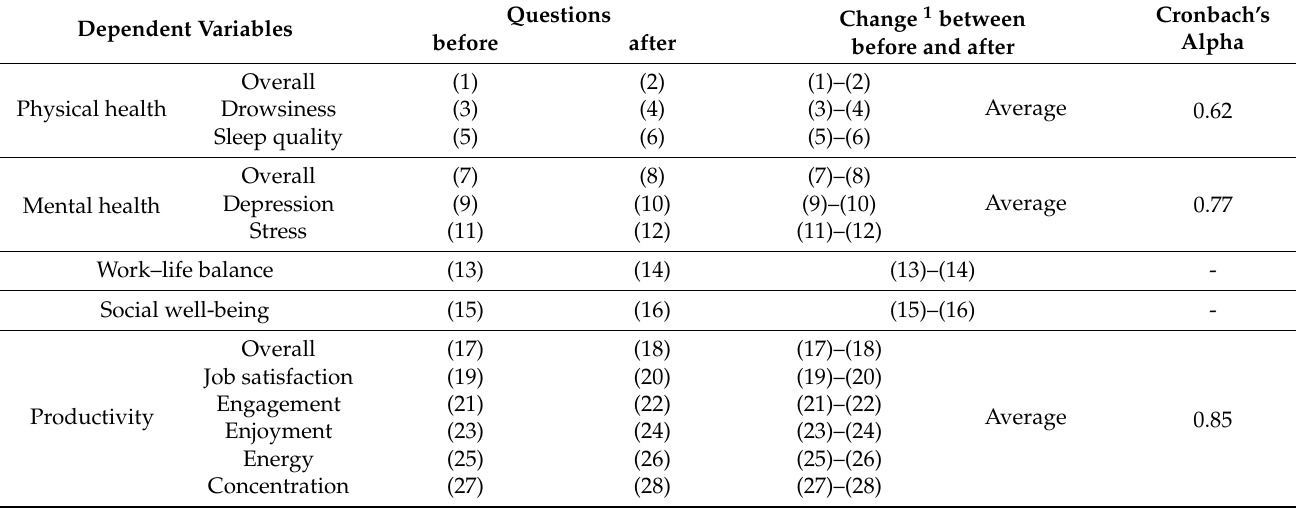
Table 2. The process of calculating changes in health and